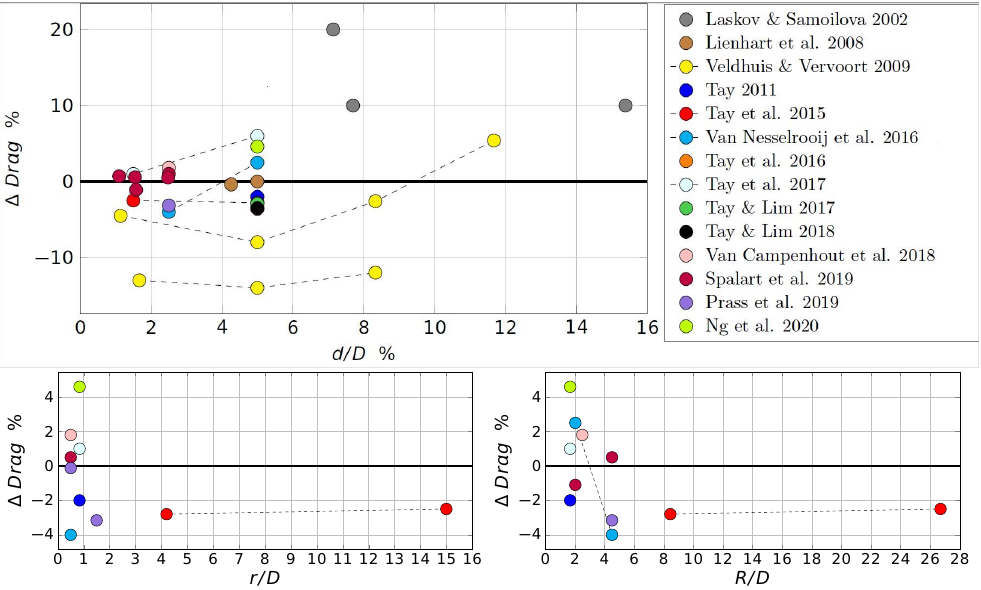
Figure 4. Drag change obtained with circular dimples versus depth ( top ) [13–24,27,31], edge curva- ture radius ( bottom left ) and radius of the spherical cap ( bottom right ). Dashed lines connect points for which only the parameter on the abscissa is